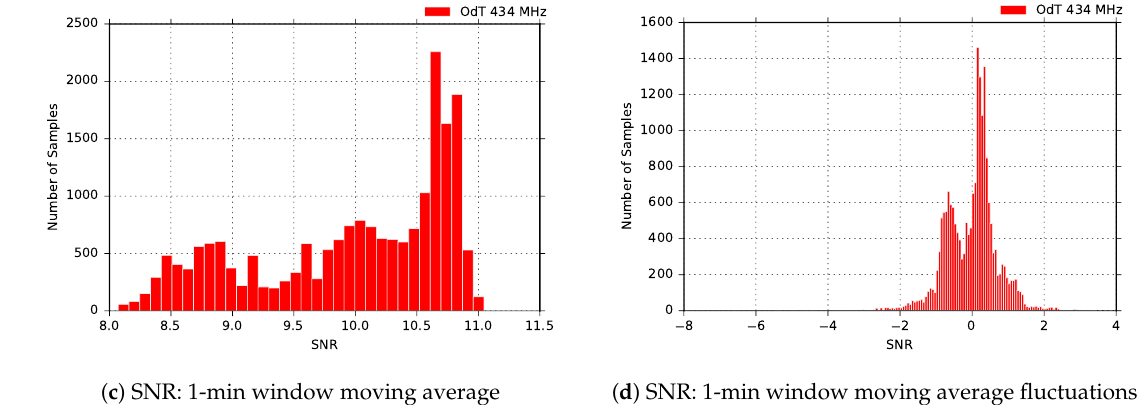
Figure 16. RSS and SNR histograms for ODT: f = 434MHz, BW = 125kHz, SF = 7, CR = 4/6, LOS.